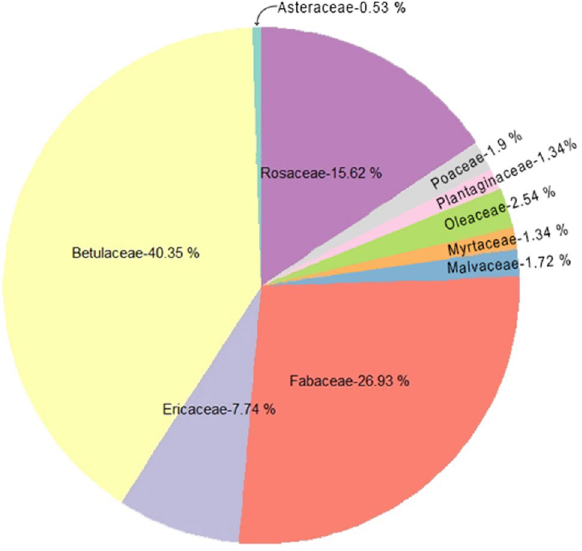
Figure 1. Pie-chart of ten major plant families and their pollen load percentage found on proboscides of